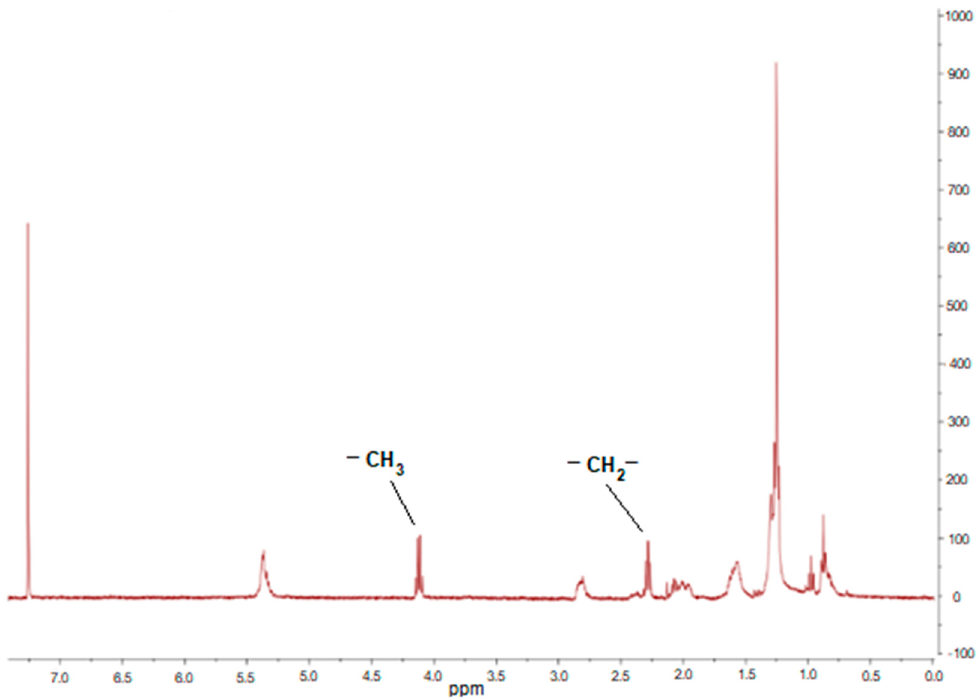
Figure 7. Typical 1 H-NMR spectrum of FAEE.